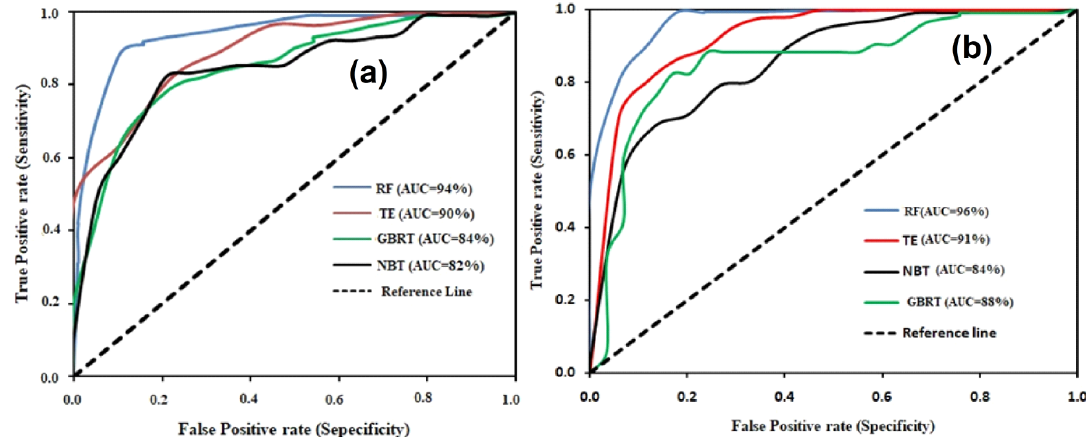
Figure 9. ROC curves showing AUC of RF, GBRT, TE, and NBT models ( a ) training dataset and ( b ) validation dataset.